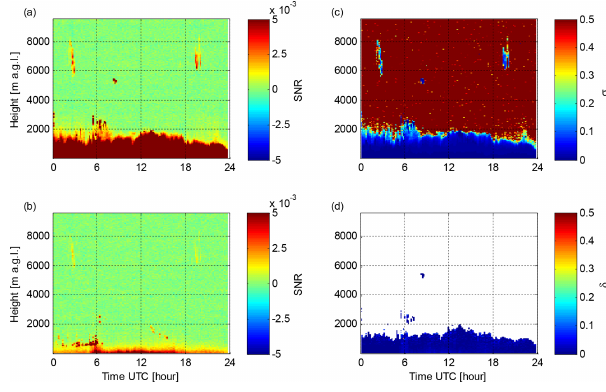
Figure 10. Limassol 20 May 2017 measurements with Halo Doppler lidar. (a) Time series of co-polar SNR at 300s integration time. (b) Time series of cross-polar SNR at 300s integration time. (c) Uncertainty in the depolarization ratio. (d) Particle linear depo- larization ratio filtered with σ δ < 0 .